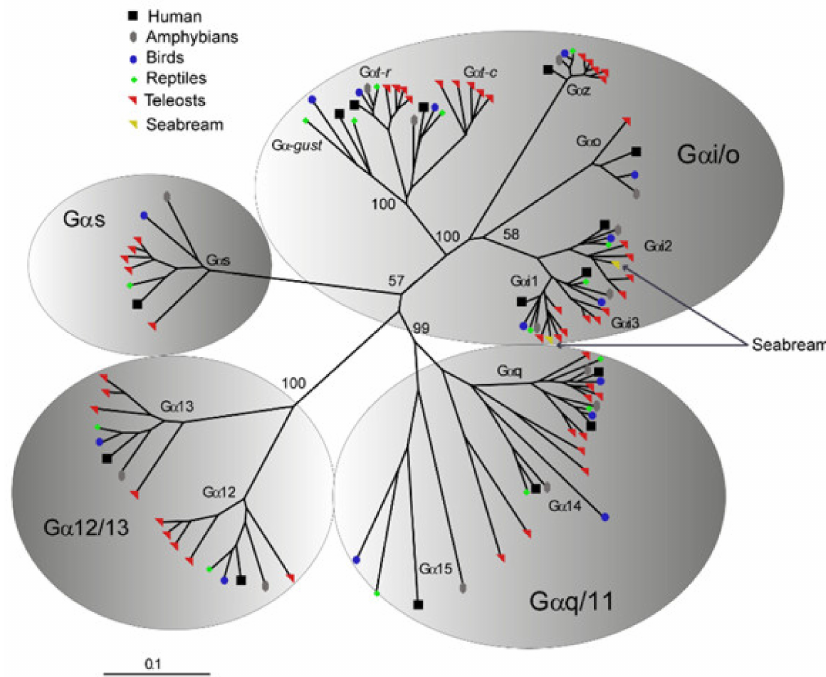
Figure 3. Radial view representation of an unrooted Neighbor-Joining tree depicting the phylogenetic relationship among ( G α ) protein subunits of Gs , Gi / Go , Gq / G11 and G12 / G13 classes of representative vertebrate homologs. saG α i1 and saG α i2 AA sequences cluster in one-to-one ortholog relationships within the corresponding G α i monophyletic clade, suggesting saG α i1-2 duplicated origin from ancient vertebrate whole genome duplications. Numbers above nodes indicate bootstrap values (based on 1000 replicates) that support the respective branch. The scale (lower left corner) indicates the mean number of AA substitutions per